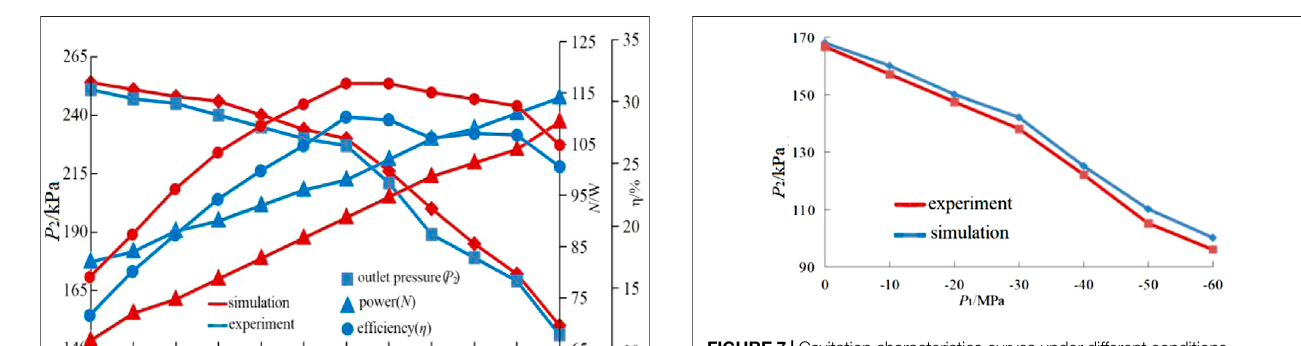
Figure 5 . The working medium of the test was low- temperature glycol aqueous solution.